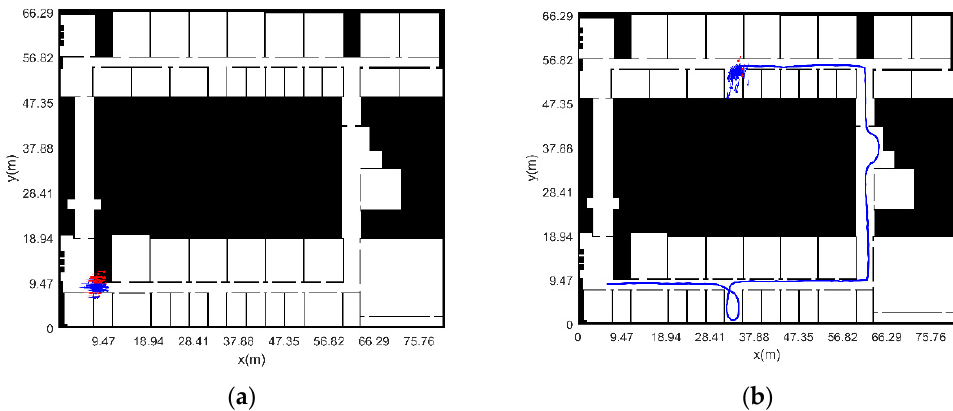
Figure 7. Sampling particle distribution and motion trace with known position and heading. ( a ) Particle distribution at initial moment. ( b ) Particle distribution in motion.